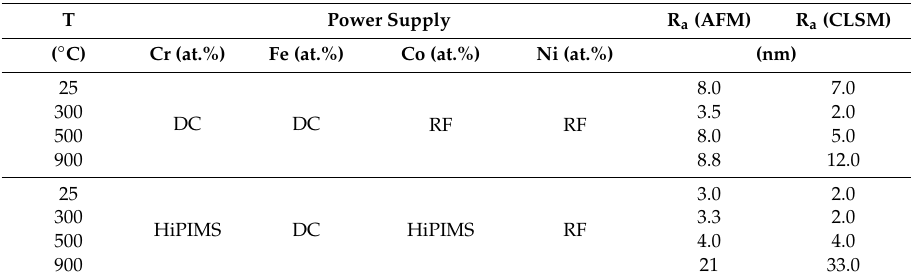
Table 2. Roughness (R a ) determined in AFM and confocal laser scanning microscope (CLSM).